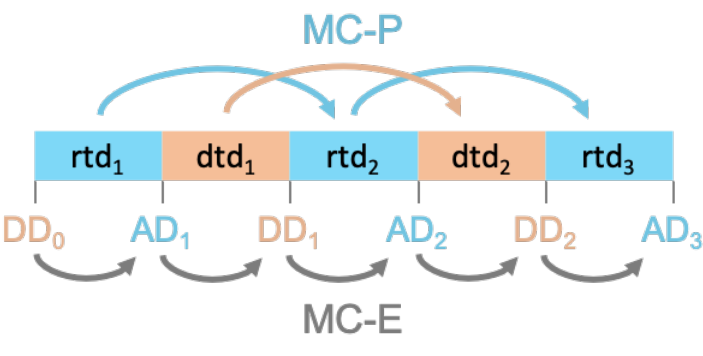
Figure 2. Visualization of dependency structures of the MC-E and MC-P